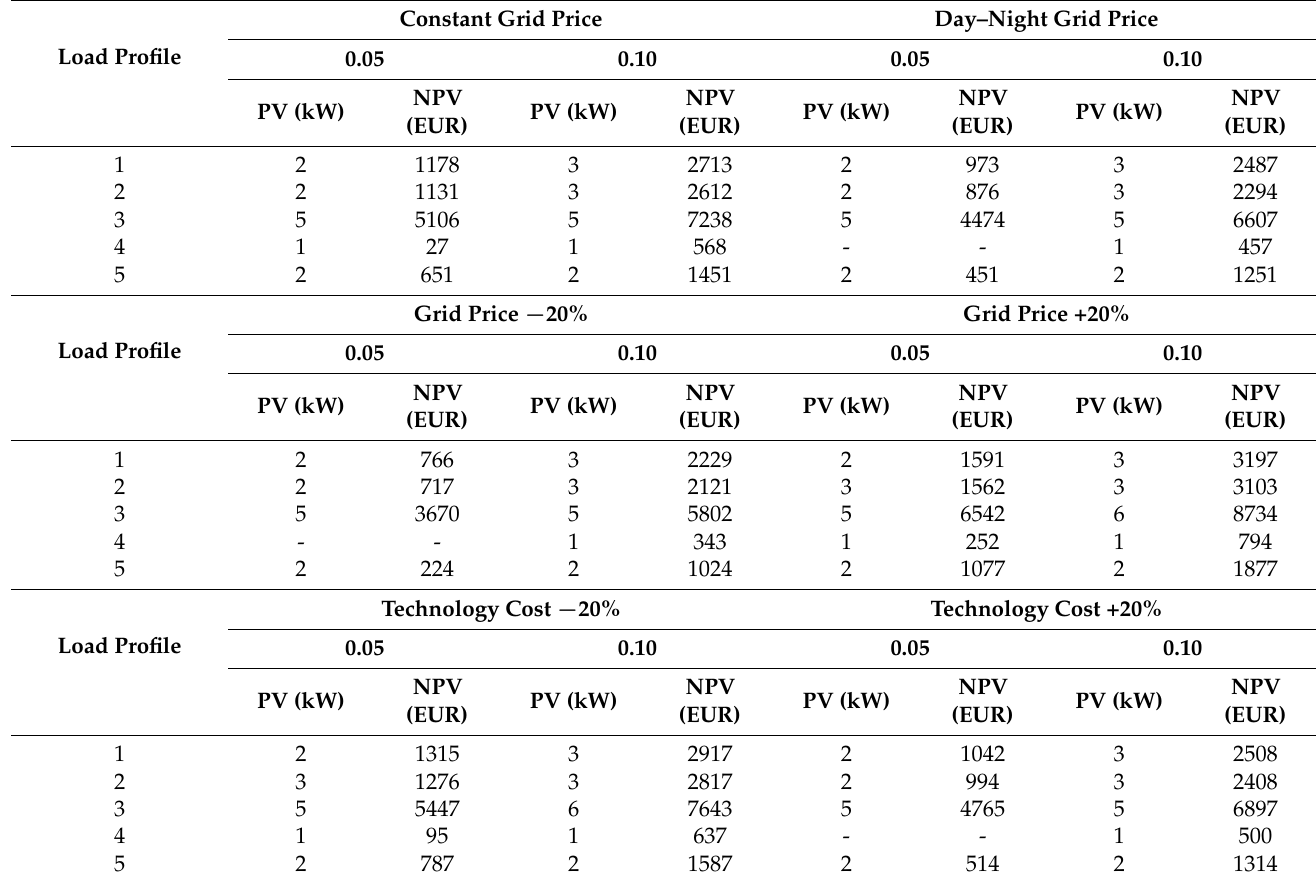
Table 5. Results of the sensitivity analysis regarding the grid and technology